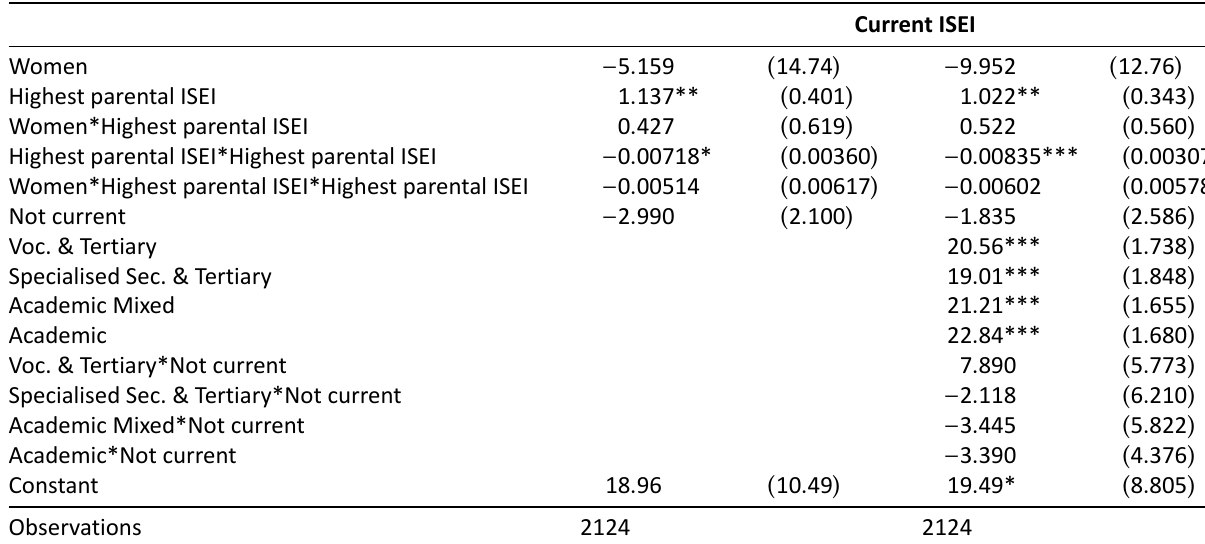
Table 7. Effects on social status (ISEI) (OLS coefficients).